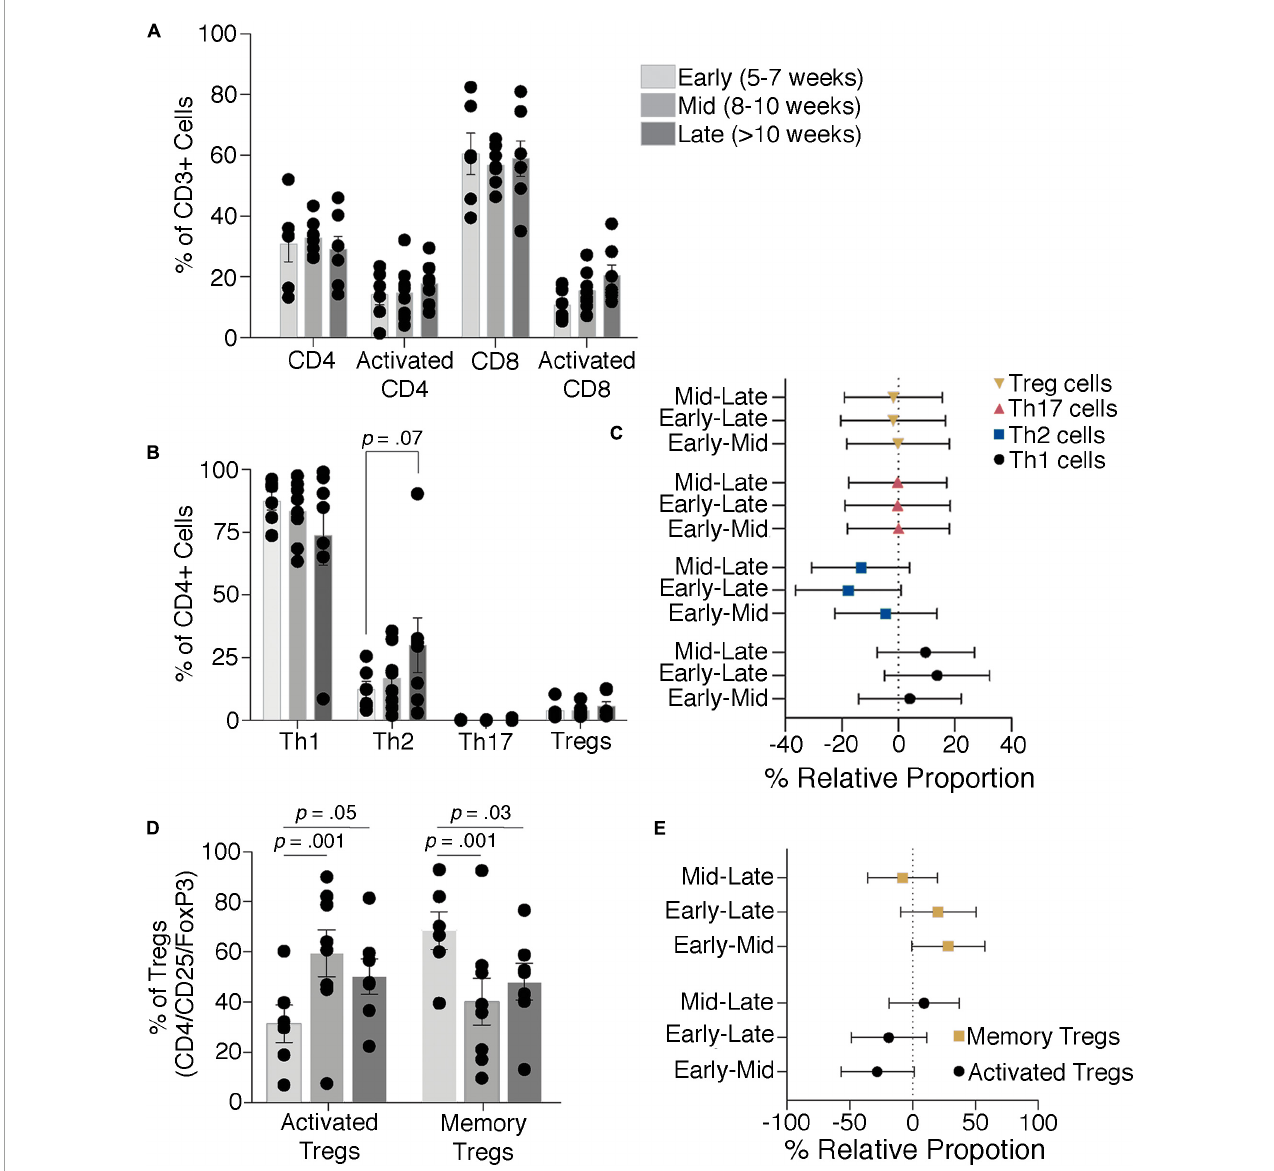
FIGURE5 T-cell dynamics through the late first to early second trimester. Proportions of total and activated decidual CD4 and CD8 T-cells (A) and Th1, Th2, Th17, and Treg cells (B,C) show no significant difference through the first trimester, although there is a trend toward an increase in Th2 cells. Activated and memory Tregs levels change with increasing gestational age (D,E) . Bars depict group means and error bars represent one standard